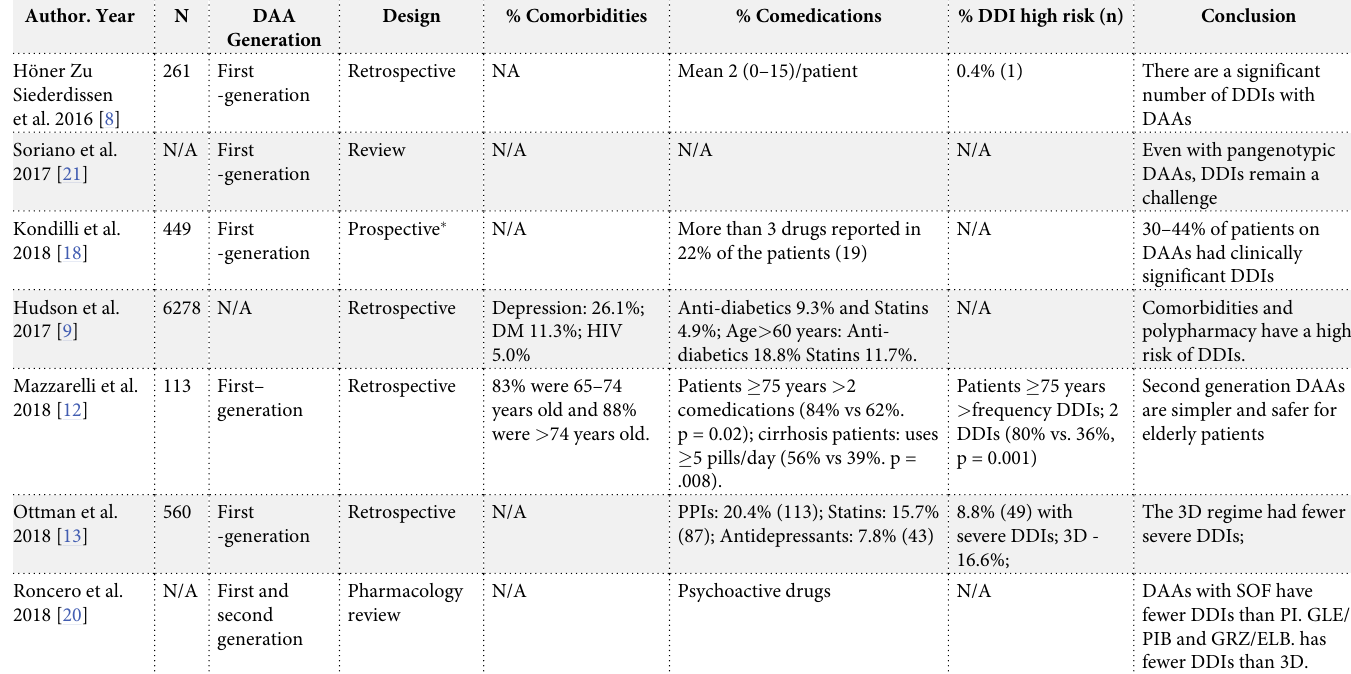
Table 5. Published studies on drug interactions with direct-acting antivirals in hepatitis C patients. Author.